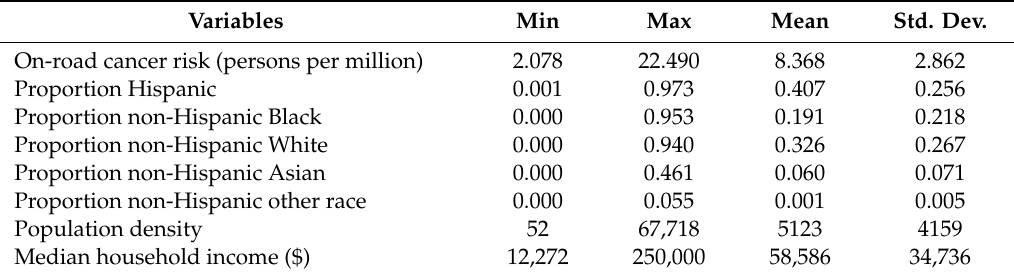
Table 1. Descriptive statistics for key variables (N = 784